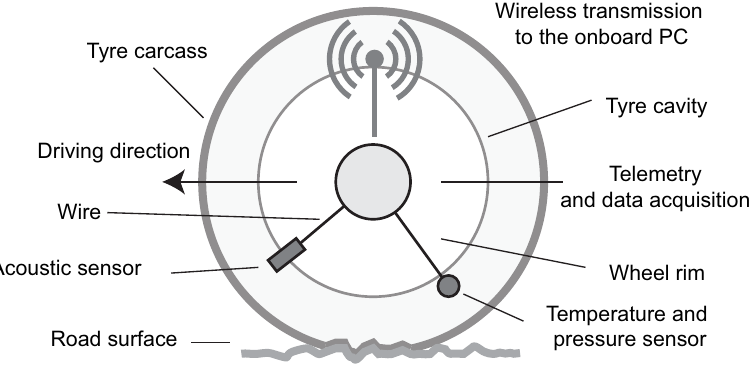
Figure 24. Experimental setup presented in Masino et al. [47]. Figure adapted by the authors from